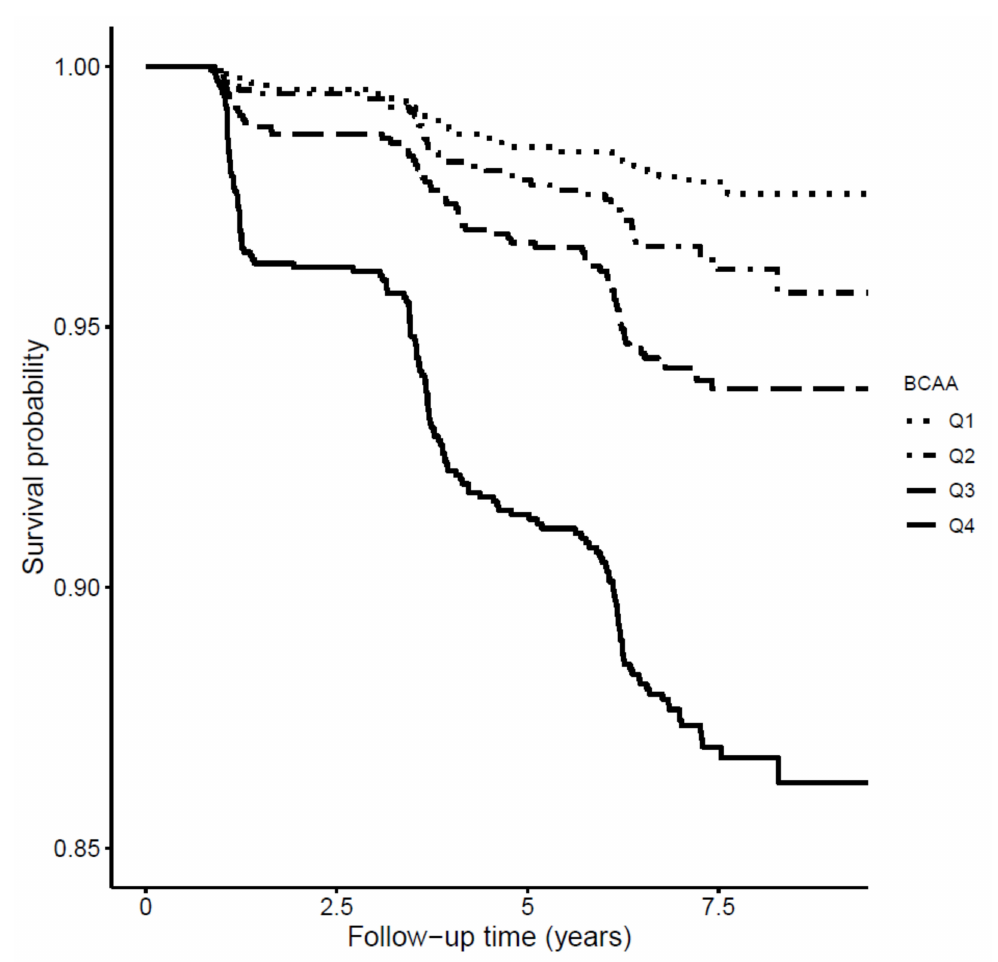
Figure 1. Kaplan-Meier curves for incident type 2 diabetes survival according to quartiles of BCAAs, by log-rank test ( p <